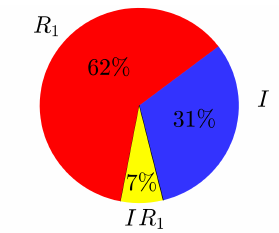
Figure 12. Pie chart representing the contribution of the different uncertainty sources to the model output variance (at t = 40 ms).